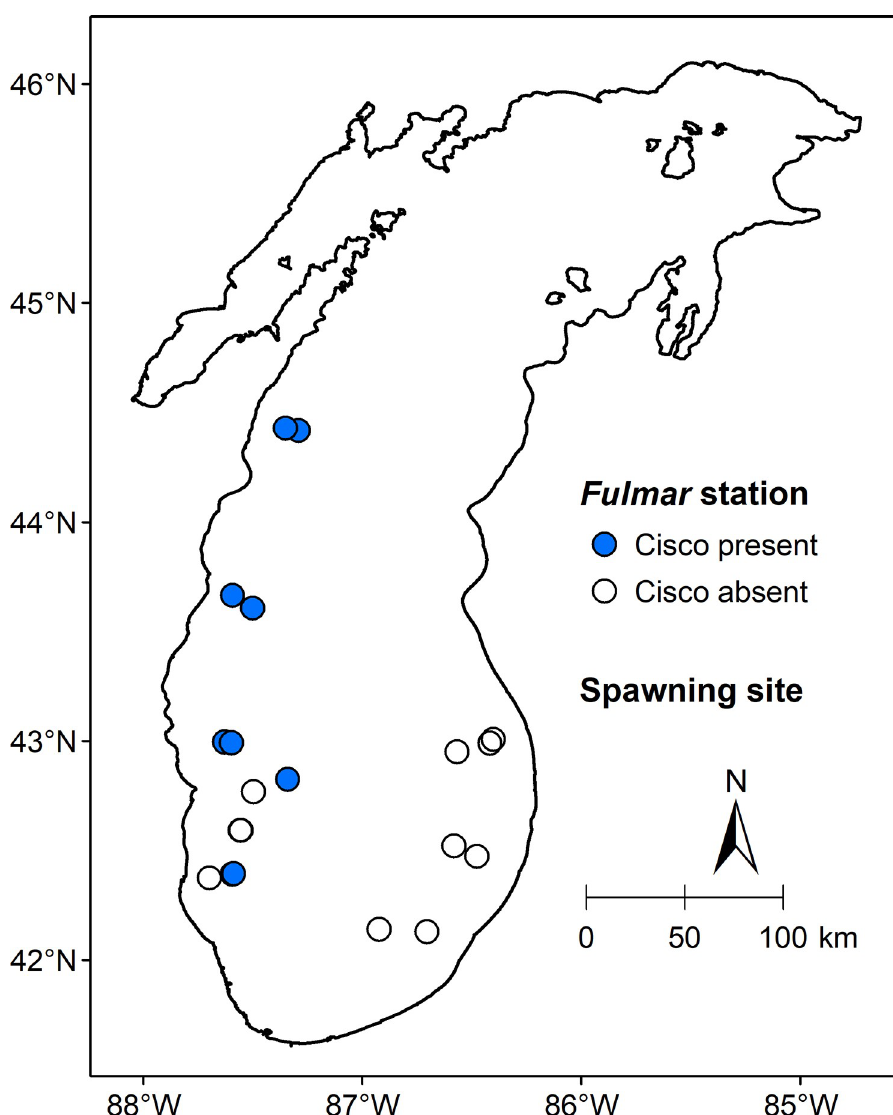
Fig 7. Historical distribution of cisco in the gravid season in Lake Michigan. Circles are Fulmar stations sampled from October 16, the earliest date when a gravid cisco was caught, to November 19, the latest date for a Fulmar lift between 1930 and 1932. Closed circles are sampling stations where ciscoes were caught, and open circles are sampling stations where no cisco was caught. The map was generated by using a geographic information system (GIS) software ArcGIS version 10.4 (http://www.esri.com/software/arcgis/). The GIS map layer for historical distribution of cisco in the gravid season was generated in this study. The GIS map layers for Lake Michigan was obtained from Great Lakes Aquatic Habitat Framework’s [25] public domain spatial database (https://glahf.org/data/).